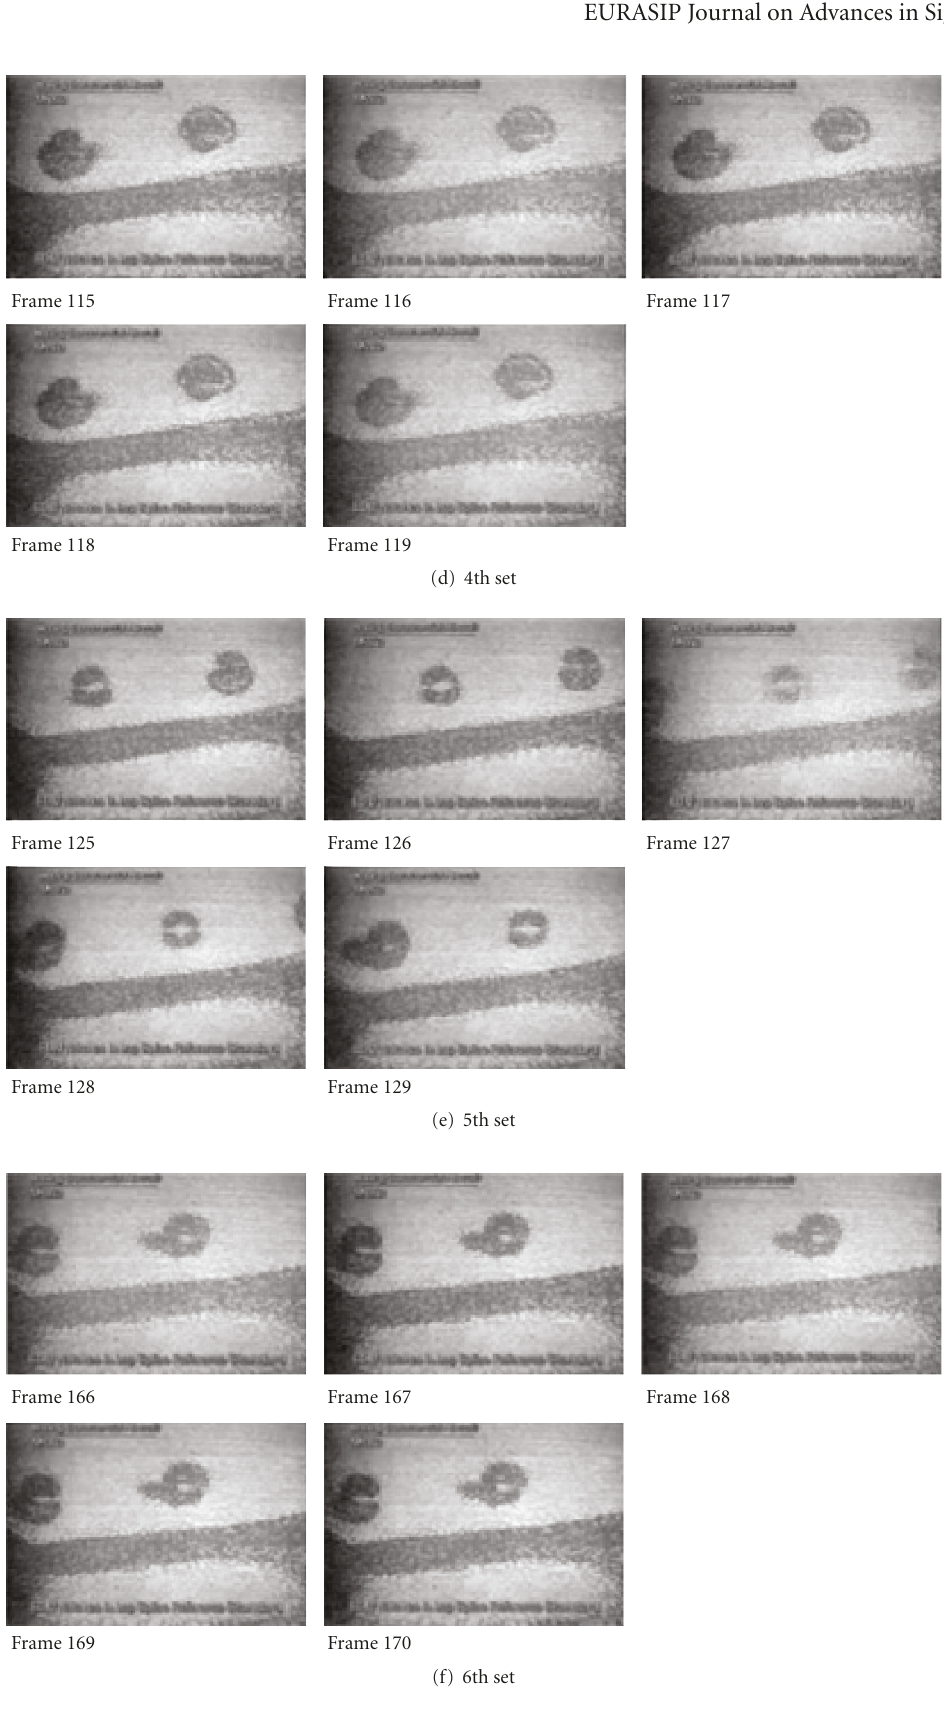
Figure 5: The set of magneto-optic images exploited in this